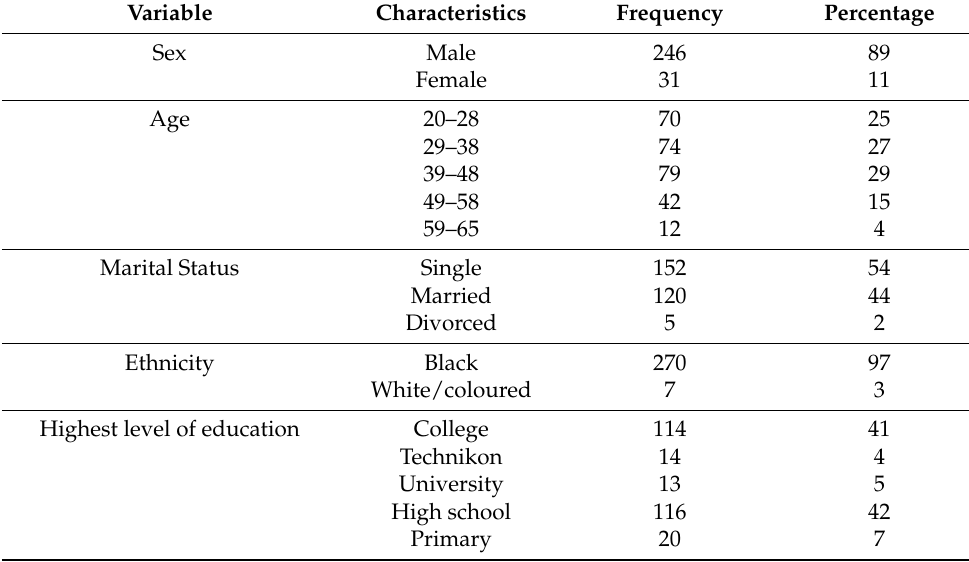
Table 1. Demographic details of